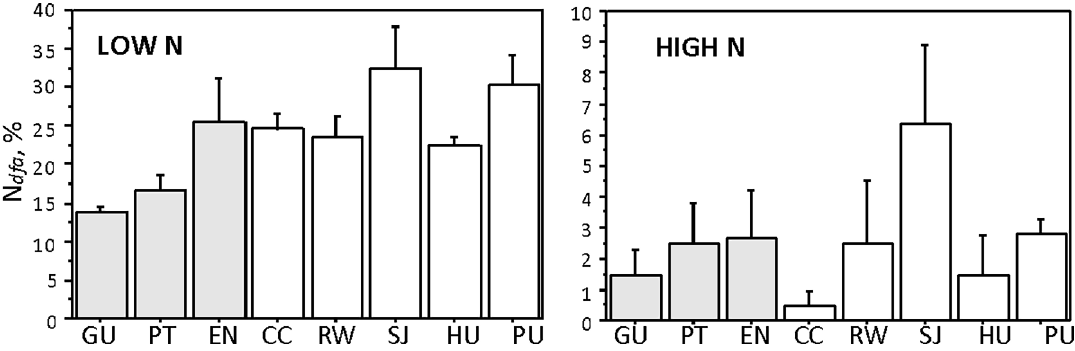
Fig 4. The proportion of N derived from N 2 fixation (N dfa ). X-axis: Clones Guillermo, GU, Puente, PT and Ensenada, EN are of variety tereticulmis ;Copacabana, CC, Rockefeller, RW, San Juan, SJ, Huanchaco, HU, and Puno, PU are clones of variety californicus . Note the differences in the y-axes. The error bars indicate the standard error of the mean (n =